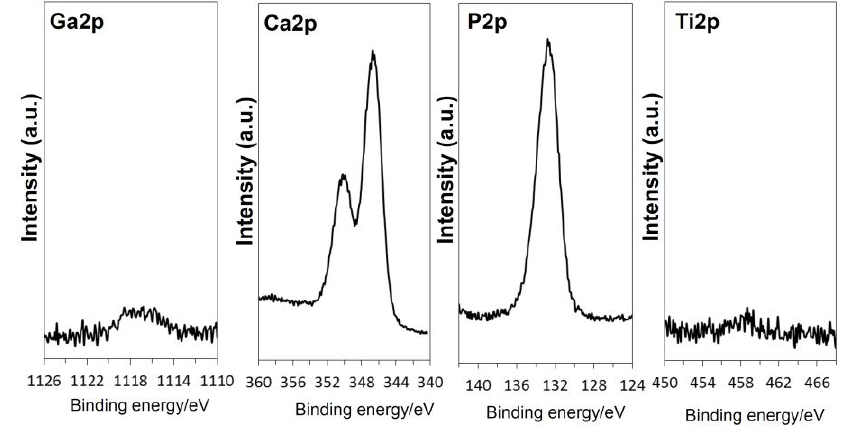
Figure 10. XPS profiles of Ga2p, Ca2p, P2p and Ti2p on Ti soaked in SBF for 7 days after NaOH- 100Ga-heat-water treatment.